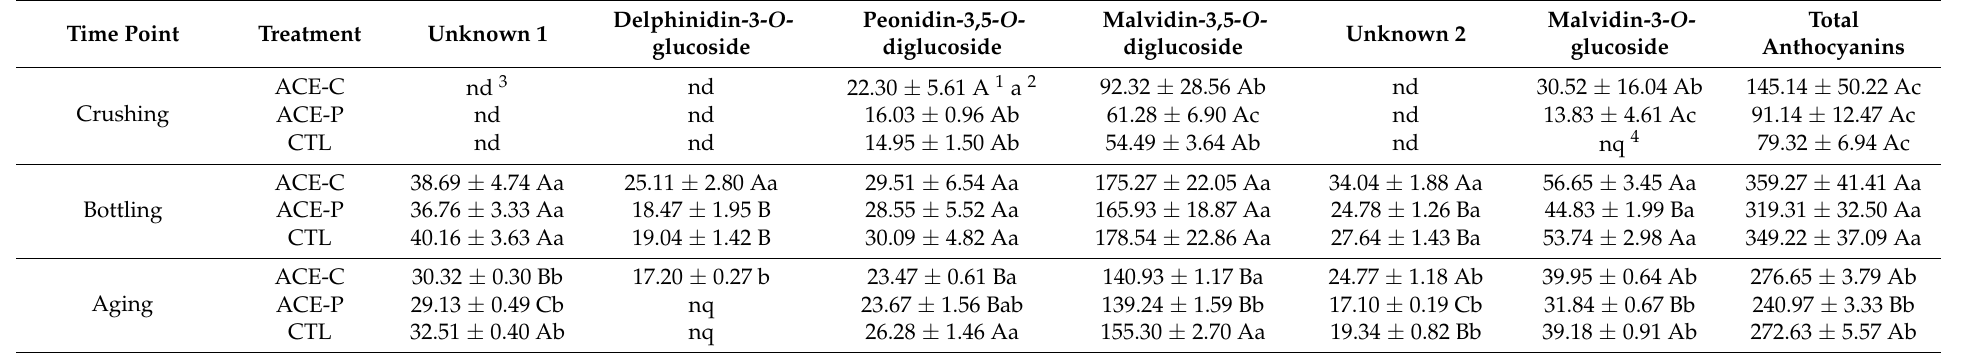
Table 2. Monomeric anthocyanins content (mg/L) in Marquette grape musts and wines at crushing, bottling, and after 5 months aging. Values are mean ± standard deviation ( n =